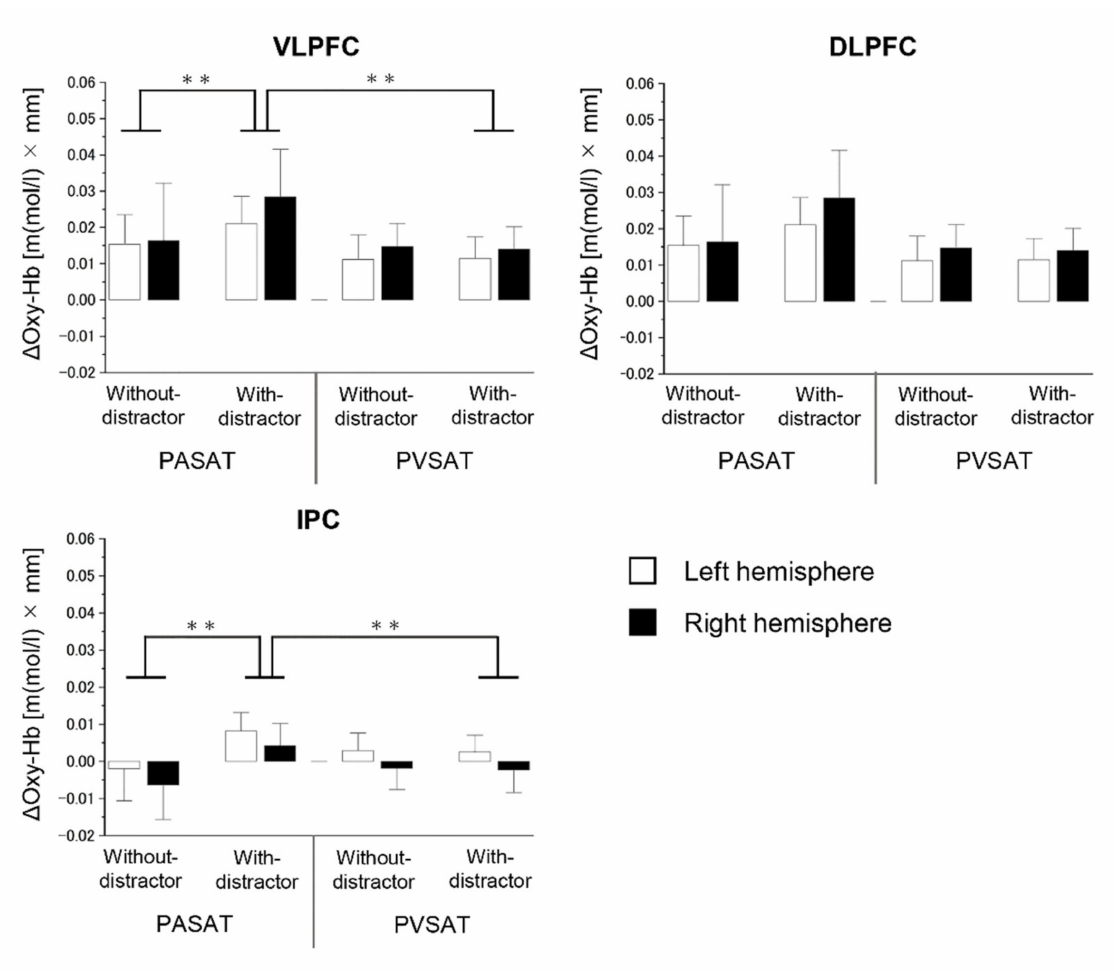
Figure 5. Results of the 2 × 2 × 2 analysis of variance of changes in Oxy-Hb concentration in each region of interest across PSATs task. The upper row shows the changes in Oxy-Hb concentration in the regions of interest (ROIs) on the VLPFC and DLPFC. The lower row shows the changes in Oxy-Hb concentration in the ROIs on the IPC. Error bars indicate the standard error. Oxy-Hb, oxygenated hemoglobin; VLPFC, ventrolateral prefrontal cortex; DLPFC, dorsolateral prefrontal cortex; IPC, Inferior parietal cortex; PASAT, Paced Auditory Serial Addition Test; PVSAT, Paced Visual Serial Addition Test. ** p <